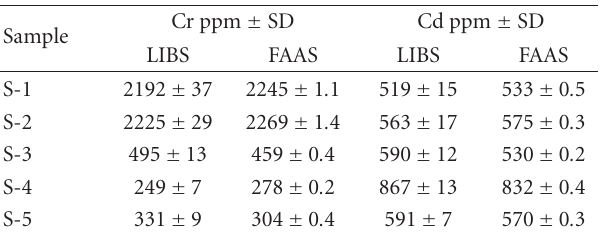
Table 1: Comparison of chromium and cadmium concentrations determined both by LIBS and FAAS in selected Tannery wastewater